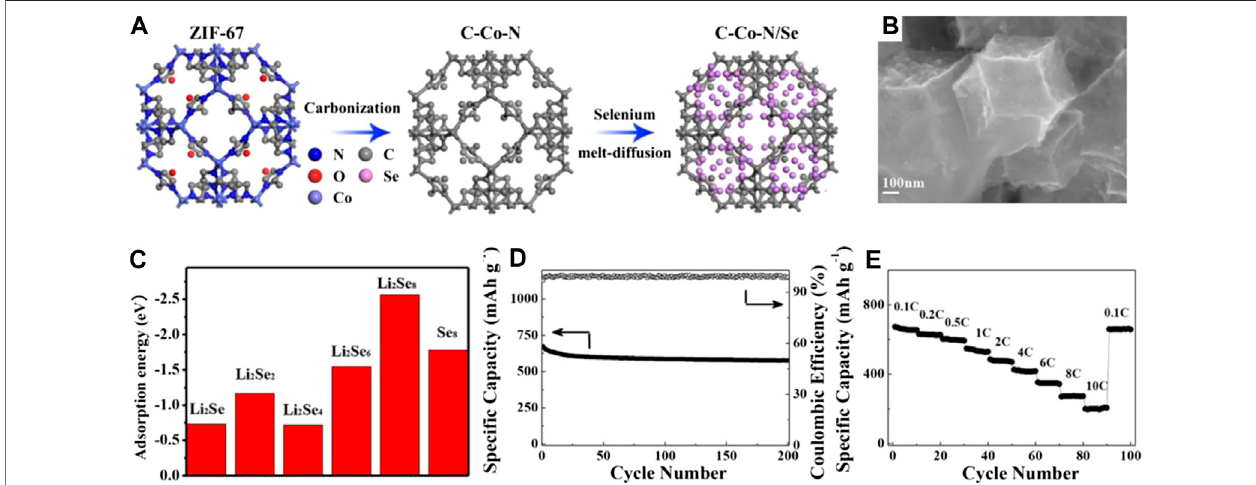
FIGURE 5 | (A) Schematic illustration of the synthetic process for C-Co-N/Se (B) SEM images of C-Co-N/Se composites (C) The calculated absorption energy values of lithium polyselenides species in C-Co-N (D) cycling stability of the C-Co-N/Se cathodes at 0.1 ° C for 200 cycles (E) rate performances at various C-rates of the C-Co-N/Se cathodes. Reproduced with permissions from the ref (He et al., 2017). Copyright © 2017 Elsevier Ltd.